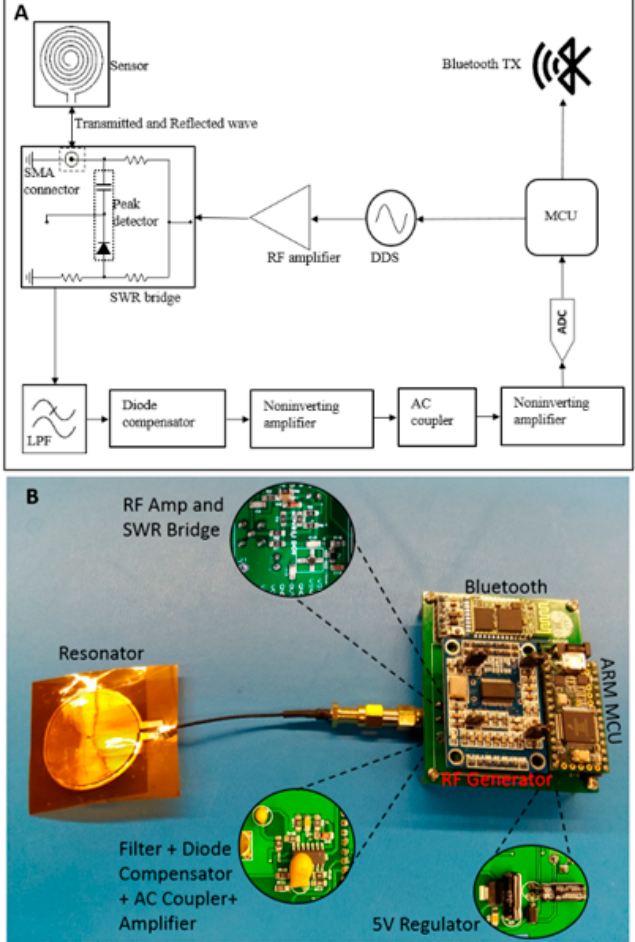
Figure 4. ( A ) Functional block diagram of the proposed sensing system, and ( B ) the developed wearable prototype showing the spiral resonator and readout hardware.